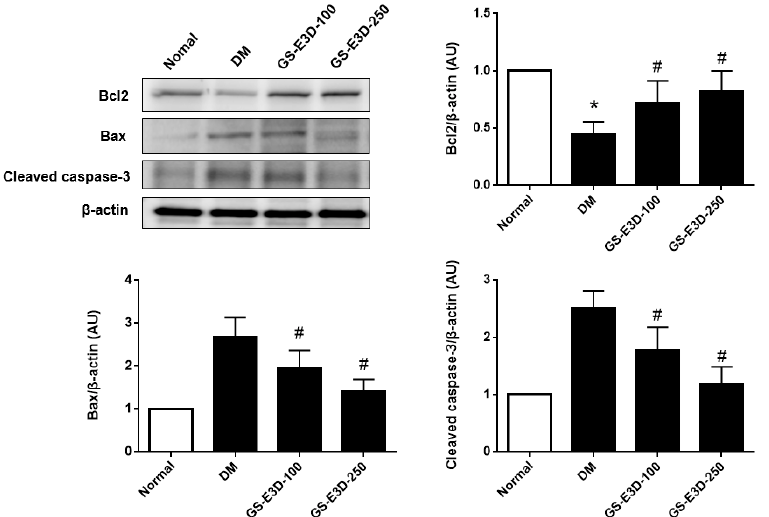
Figure 5. The expressions of apoptosis-related proteins. Relative protein levels were assessed by Western blot analysis. The blots of each protein were normalized to β -actin. All data are presented as the mean ± standard deviation (n = 6). * p < 0.05 vs. Normal group; # p < 0.05 vs. DM group.